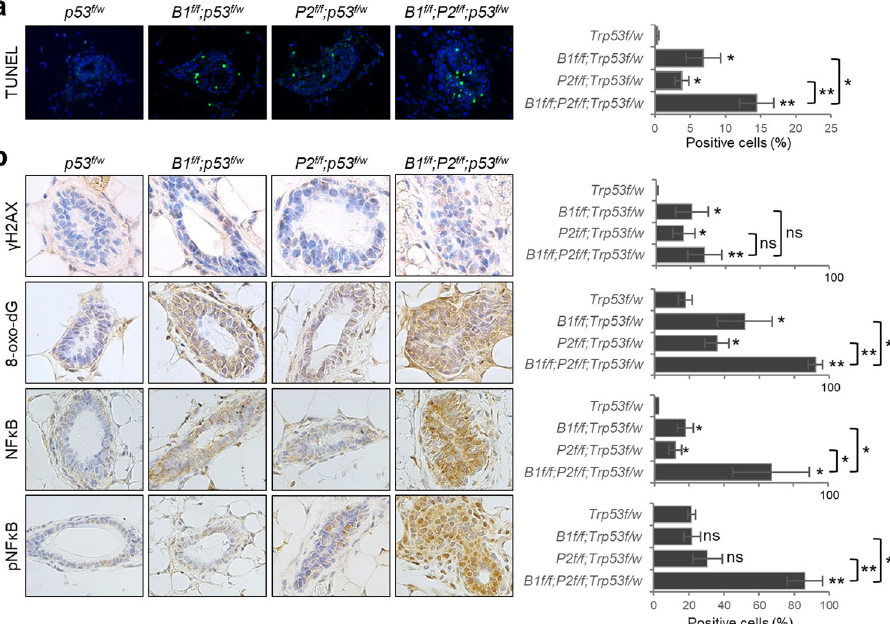
Fig. 4 Analyses of mammary glands of 10-week-old model mice. a Representative images and quanti fi cations of TUNEL signals in the mammary glands. b Representative IHC images and quanti fi cations of positive cells for γ H2A.X, 8-oxo-dG, NF κ B p65, and phospho-NF κ B p65 in the mammary glands. Three mice of each genotype were used. Error bars represent SD. * p < 0.05; ** p < 0.01; *** p <